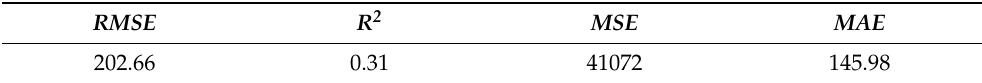
Figure 15. Response (Sa) vs. fractal dimension Df Narrow Neural Network model and their 6th degree fit. Table 5. The main statistical results of the Narrow Neural Network